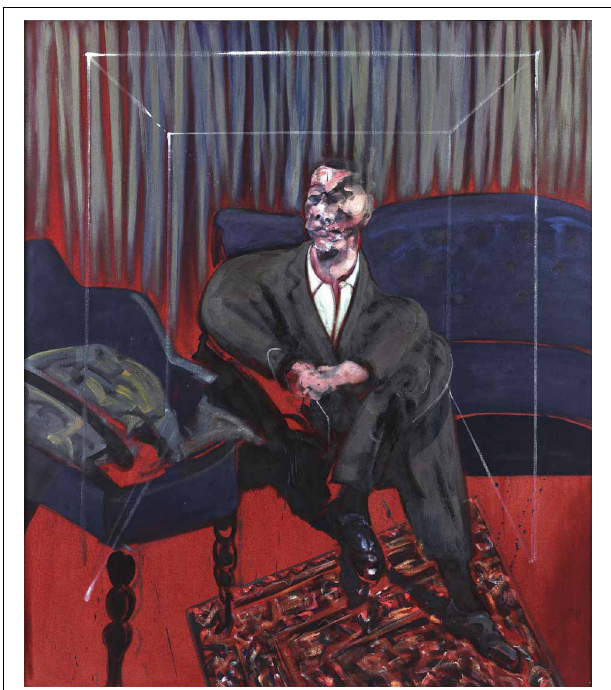
FIGURE 14 | Francis Bacon— Seated Figure, 1961. © The Estate of Francis Bacon. All rights reserved. DACS